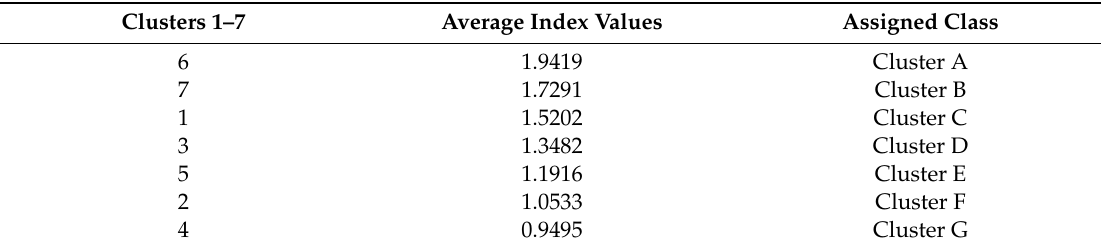
Table 1. Arrangement sequence of clusters based on average index values of each cluster.